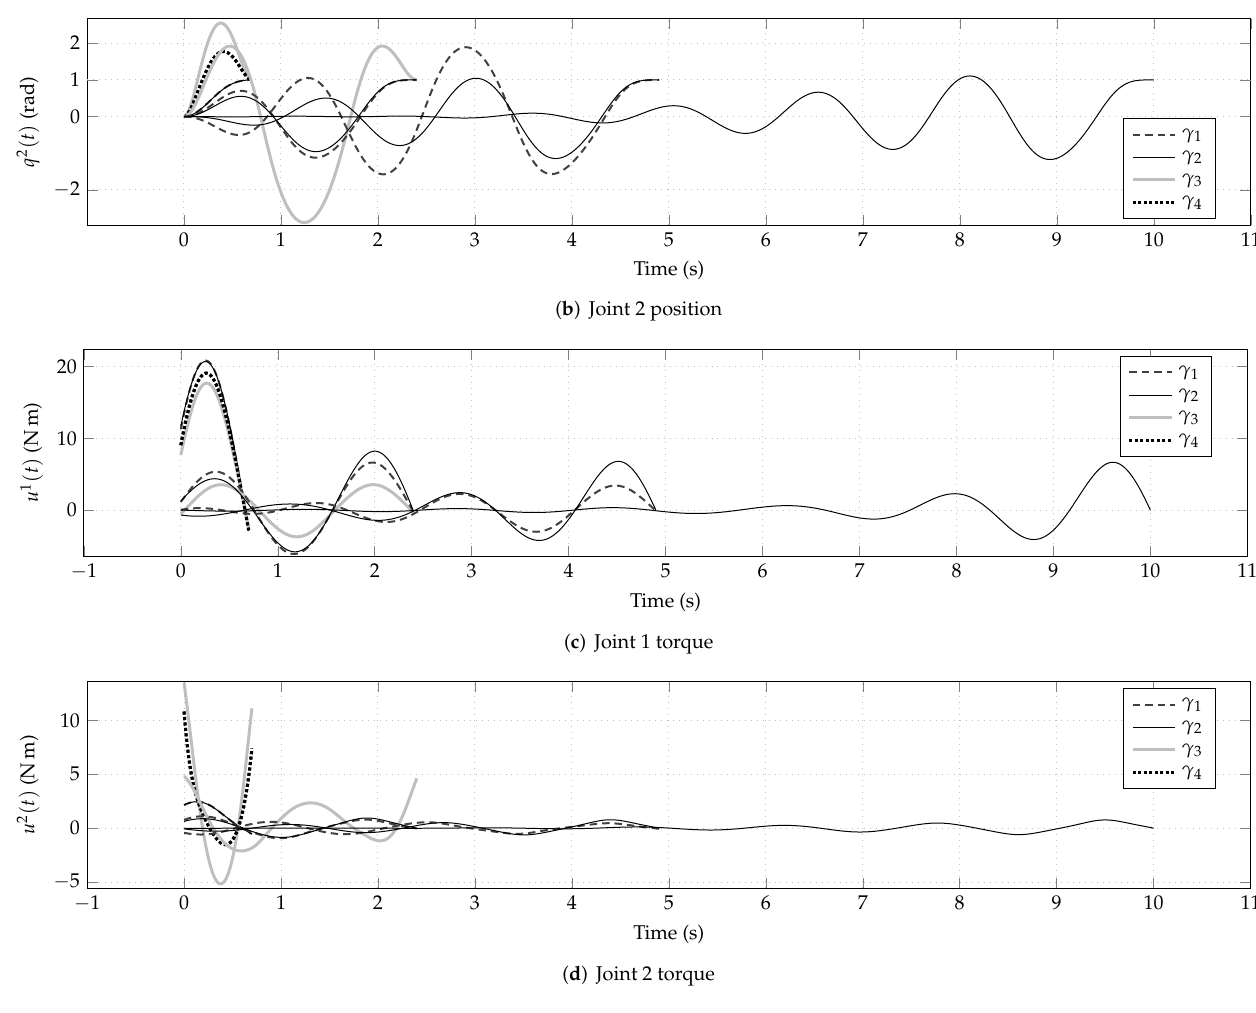
Figure 6. Numerical solution of the optimal control for an upward motion (see Step 1 of Section 6.1.3). Optimal torque and position evolution along four simulated trajectories: T = 0.7s, T = 2.4s, T = 4.9s, and T = 10s. Trajectory durations correspond to values of T in Table 1, which are the maximum values at which NDSolve successfully determined a solution with the exception of T = 10s for γ 2 . Higher values of T and narrower motions are achieved with the invariants γ 1 and γ 2 .